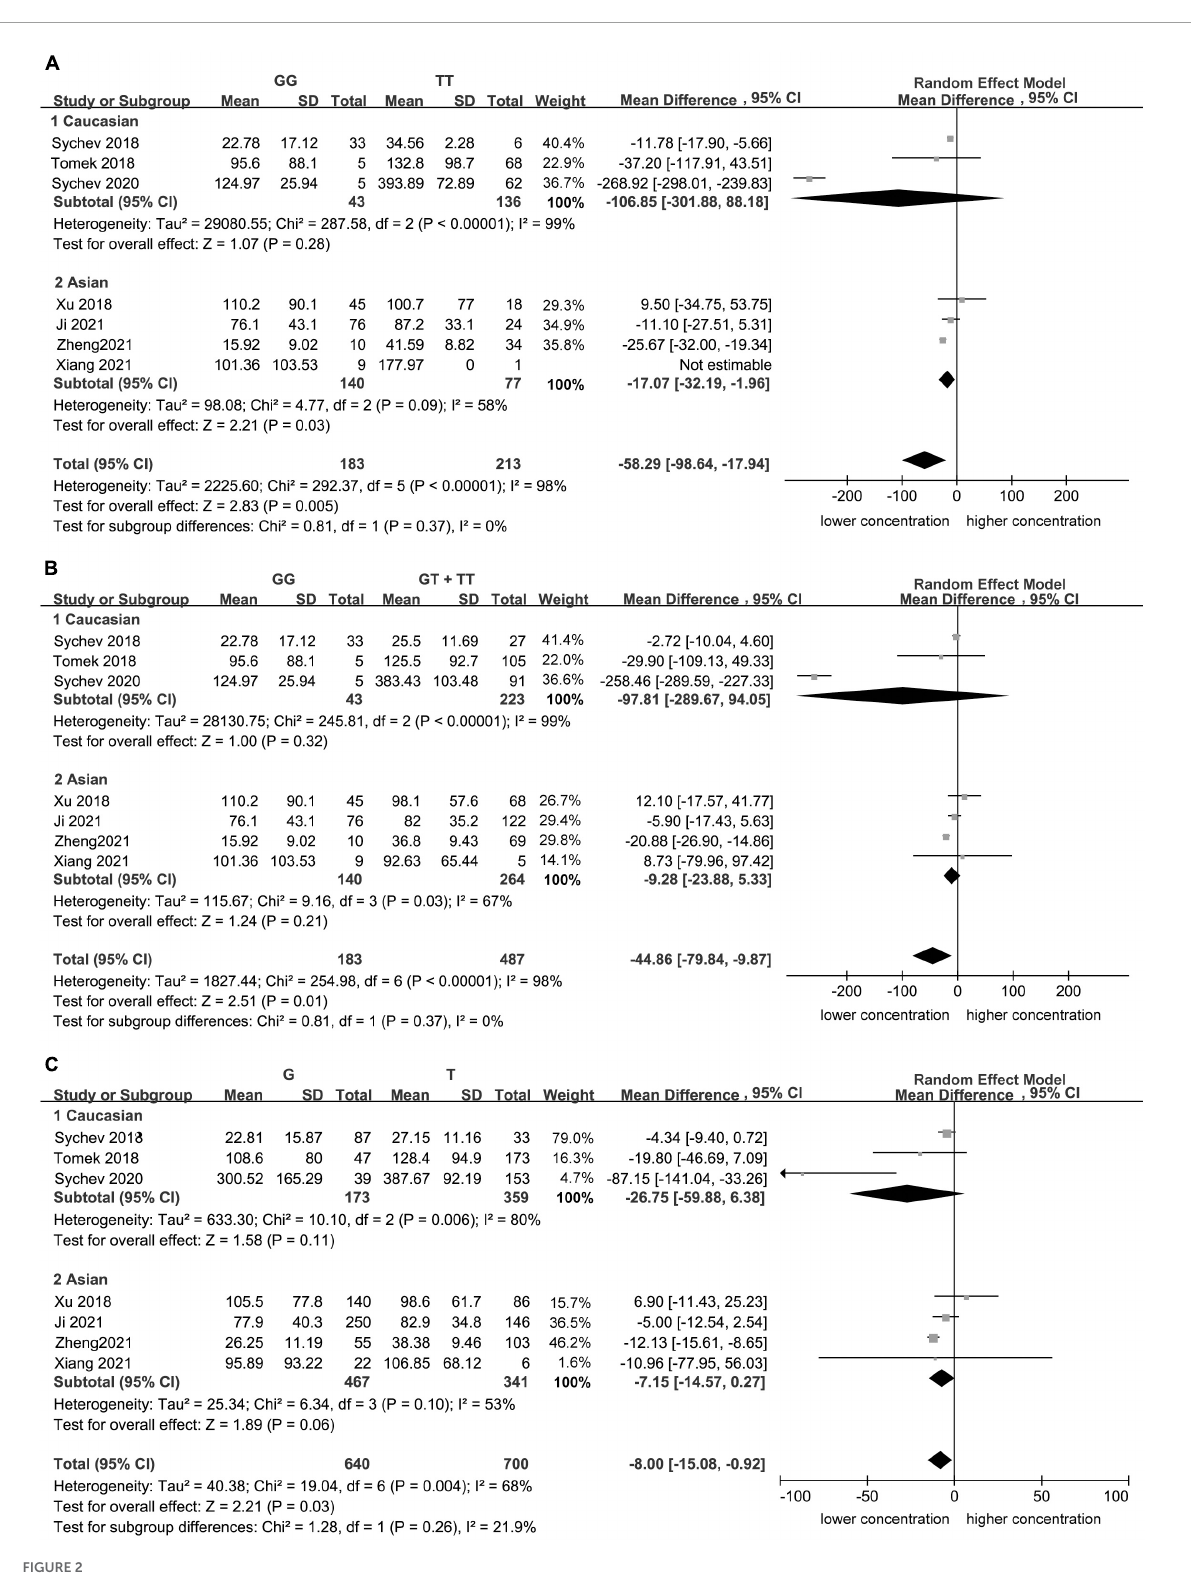
FIGURE2 Subgroup analyses for the association between carboxylesterase 1 ( CES1 ) rs2244613 polymorphism and the trough plasma concentration of dabigatran: (A) homozygote model, (B) recessive model, and (C) allelic